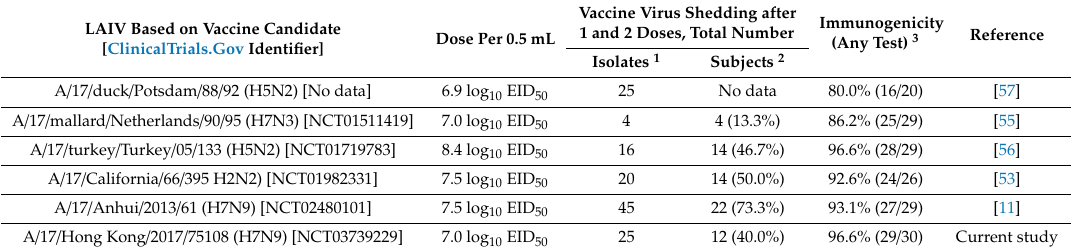
Table 4. Vaccine virus shedding and immunogenicity of potential pandemic LAIVs on L17 MDV backbone in healthy